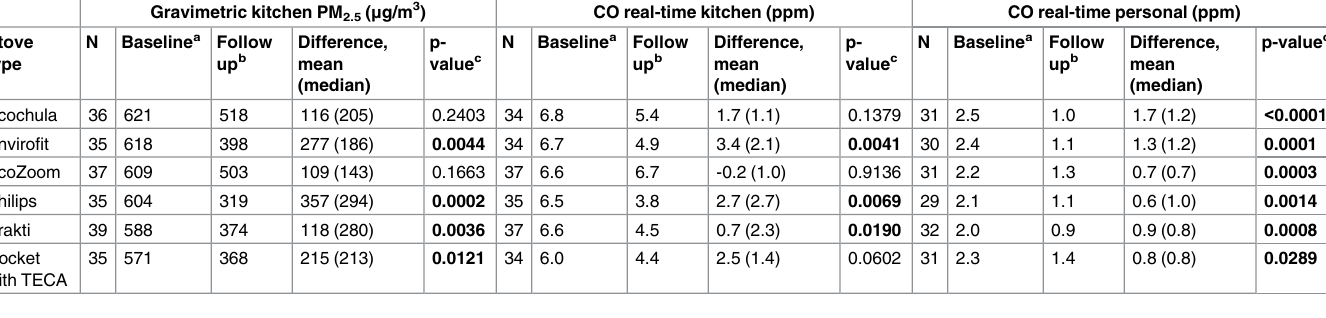
Table 3. Gravimetric PM 2.5 ( μ g/m 3 ) and kitchen and personal (woman) CO real time (ppm) 48-hour concentration by stove type.